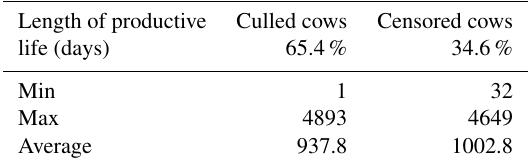
Table 1. A summary of statistics for length of productive life of Holstein